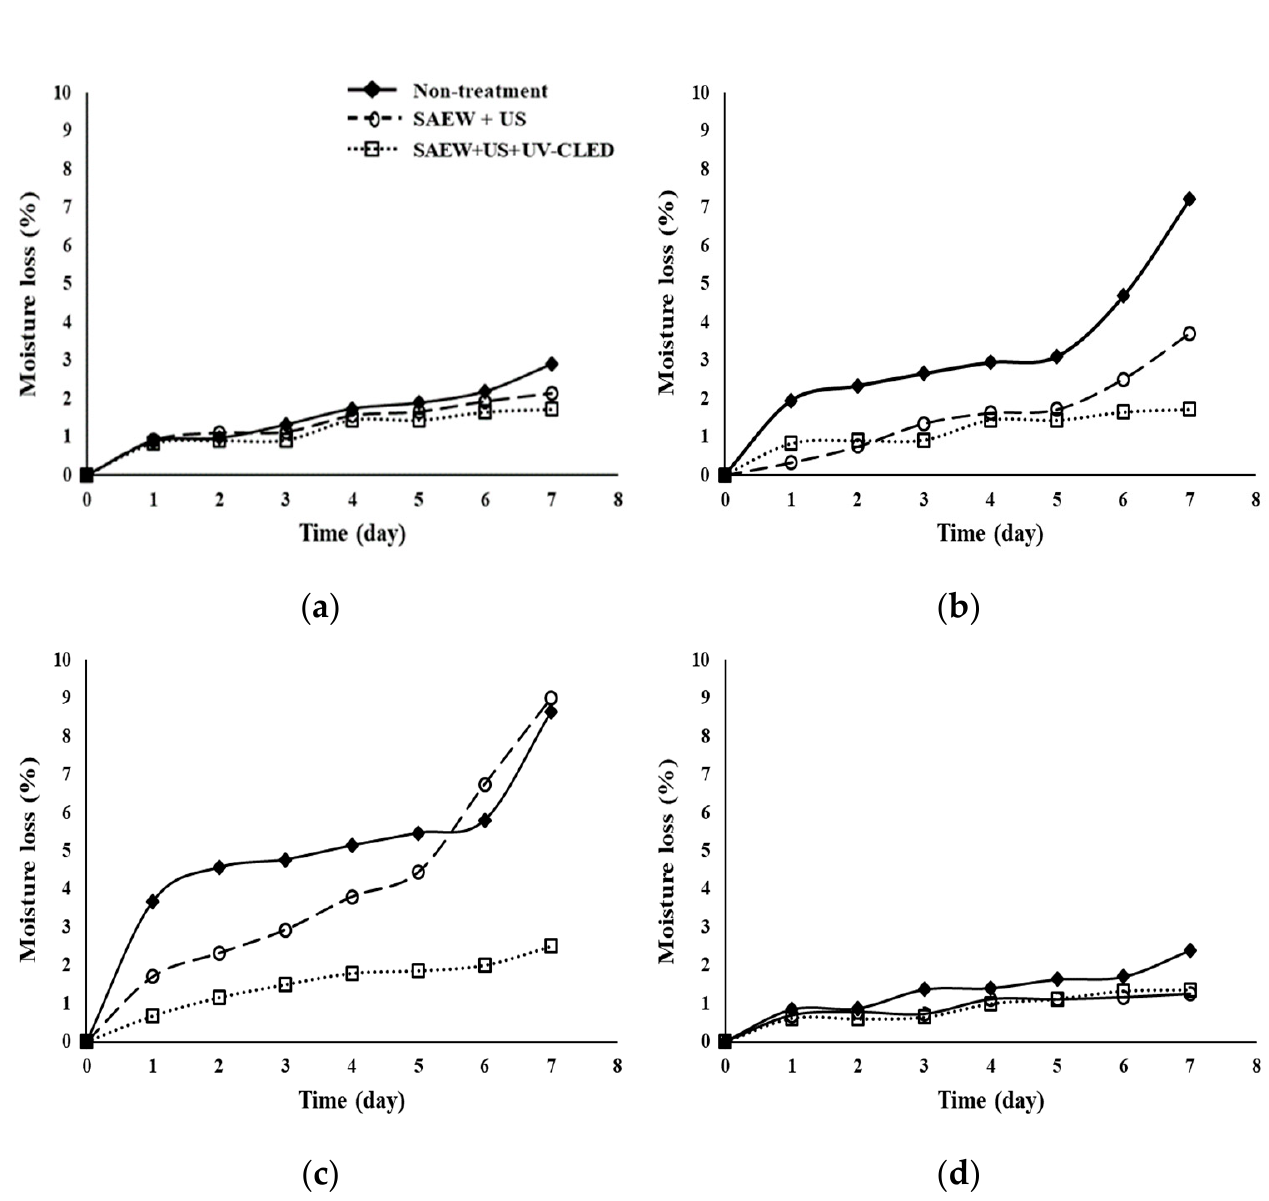
Figure 4. Effect of combined treatment on the moisture loss in various fresh-cut vegetables stored for 7 days at 5 °C. ( a ) Carrot, ( b ) celery, ( c ) cabbage, ( d ) paprika; non-treatment, no extra wash with a sanitizer; SAEW, slightly acidic electrolyzed water; US, ultrasounds; UV-C LED, ultraviolet-C light-emitting diodes (275 nm); non-treatment, no extra wash with a sanitizer.